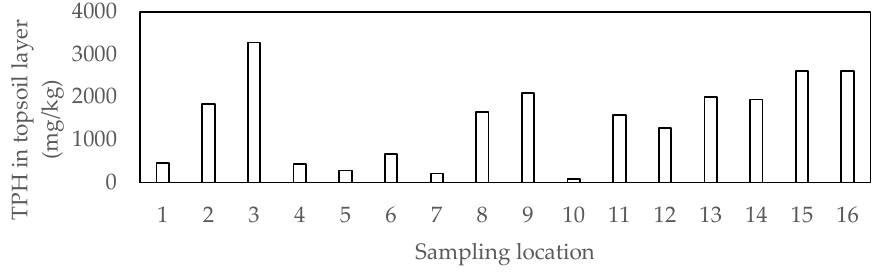
Figure 3. TPH in the surface soil layer (0–5 cm) for the 16 sampling locations.